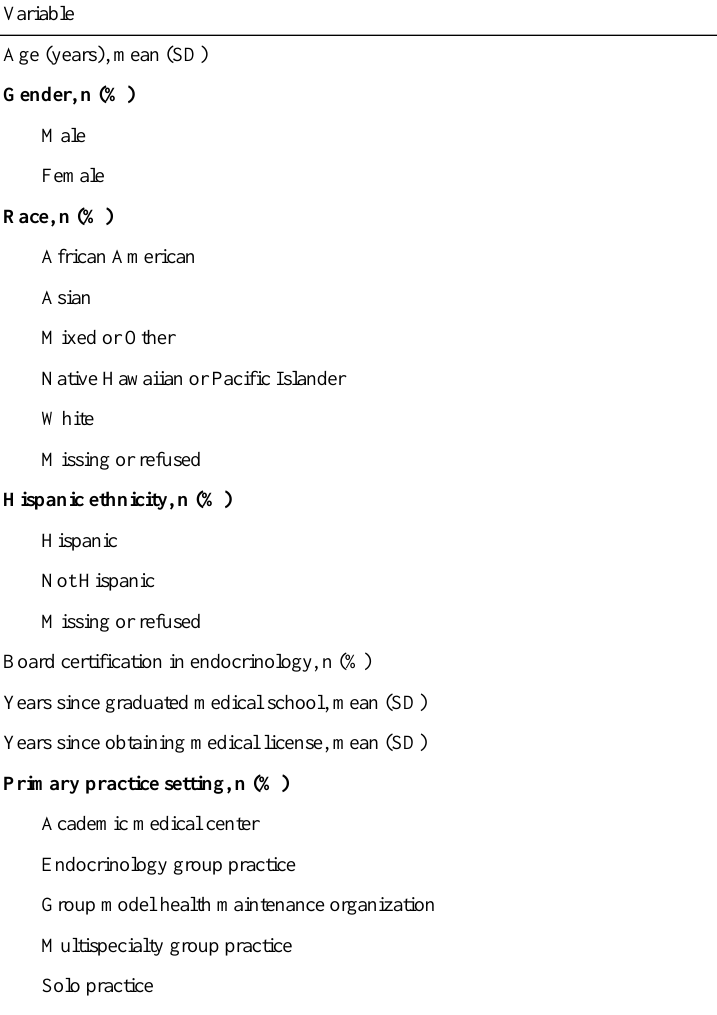
Table 1. Participant demographics (N=10).